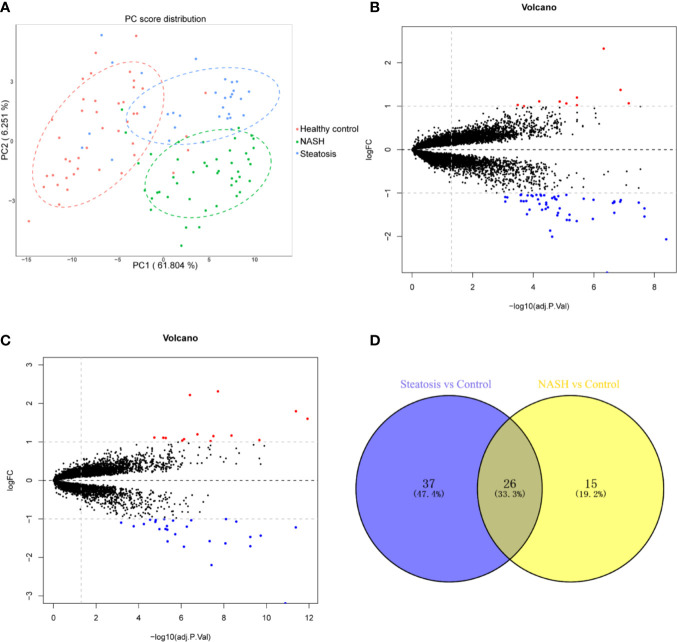
Identification of differentially expressed genes (DEGs) in both NASH and steatosis subjects when compared to healthy controls. (A) Principal component analysis (PCA) showing that steatosis patients, NASH patients, and healthy subjects are clearly separated into distinct clusters. (B) Volcano plot showing 10 up-regulated genes (red dots) and 53 down-regulated genes (blue dots) in steatosis patients when compared to healthy controls; log fold change (FC) >1, P <0.05. (C) Volcano plot showing 14 up-regulated genes (red dots) and 27 down-regulated (blue dots) in NASH patients when compared to healthy controls; log fold change (FC) >1, P <0.05. (D) Venn diagram displaying 26 DEGs present in both NASH and steatosis subjects.